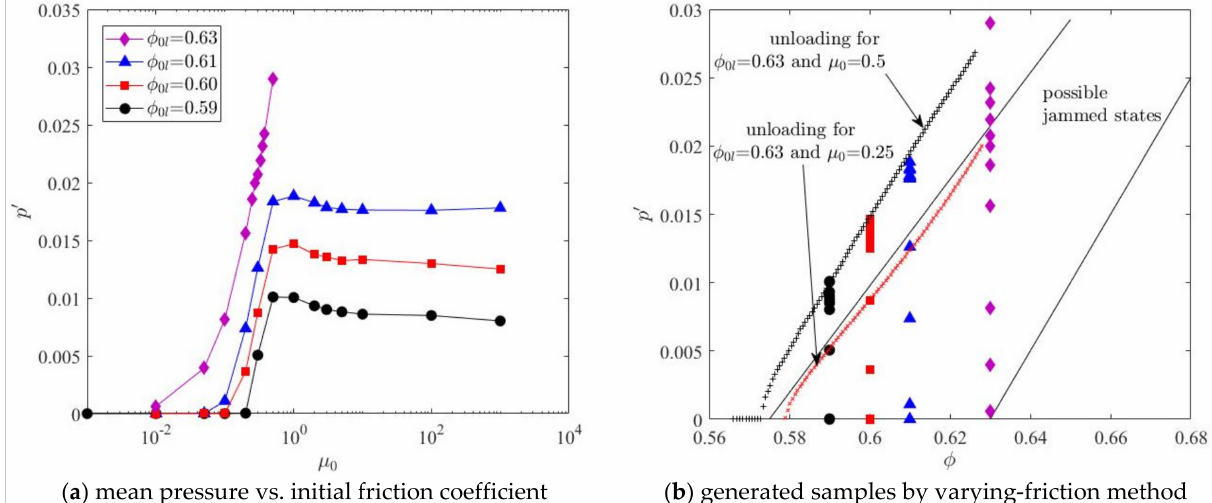
Figure 3. Varying-friction